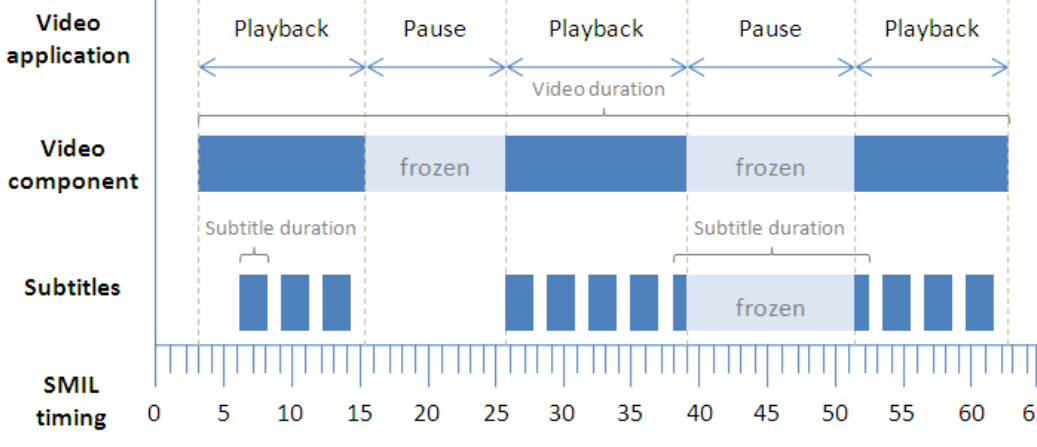
Figure 4. Strip diagram of basic timing support together with two video pause